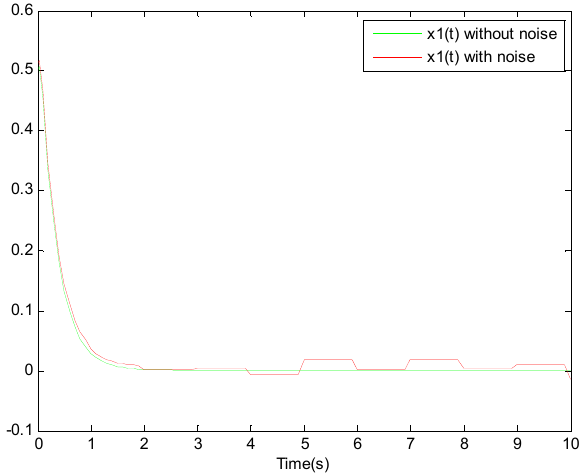
Figure 17. The state evolution x 1 ( t ) with σ =